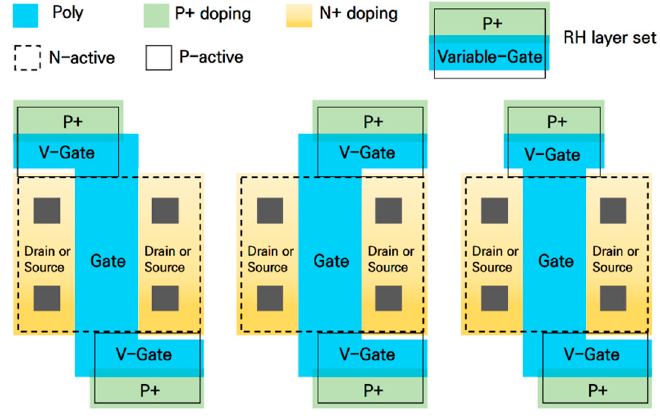
Figure 8. Structural diagram of the RH variable-gate n-MOSFET application.